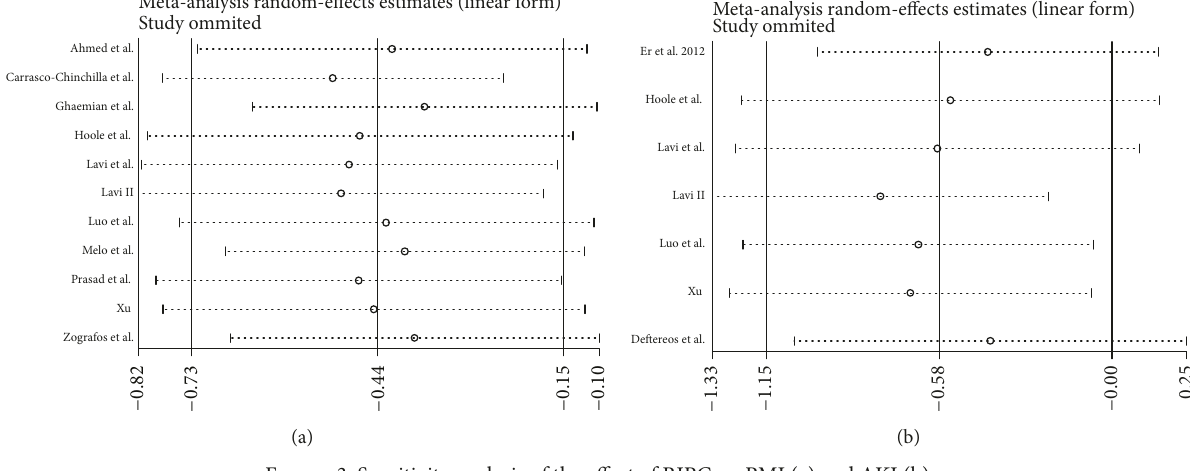
𝑃 = 0.759 ), the use of statins (coef.: − 0.05 [−0.15; 0.05] , 𝑃 = 0.35 ), and the use of angiotensin-converting enzyme inhibitors (coef.: 0.007 [−0.049; 0.064] , 𝑃 = 0.697